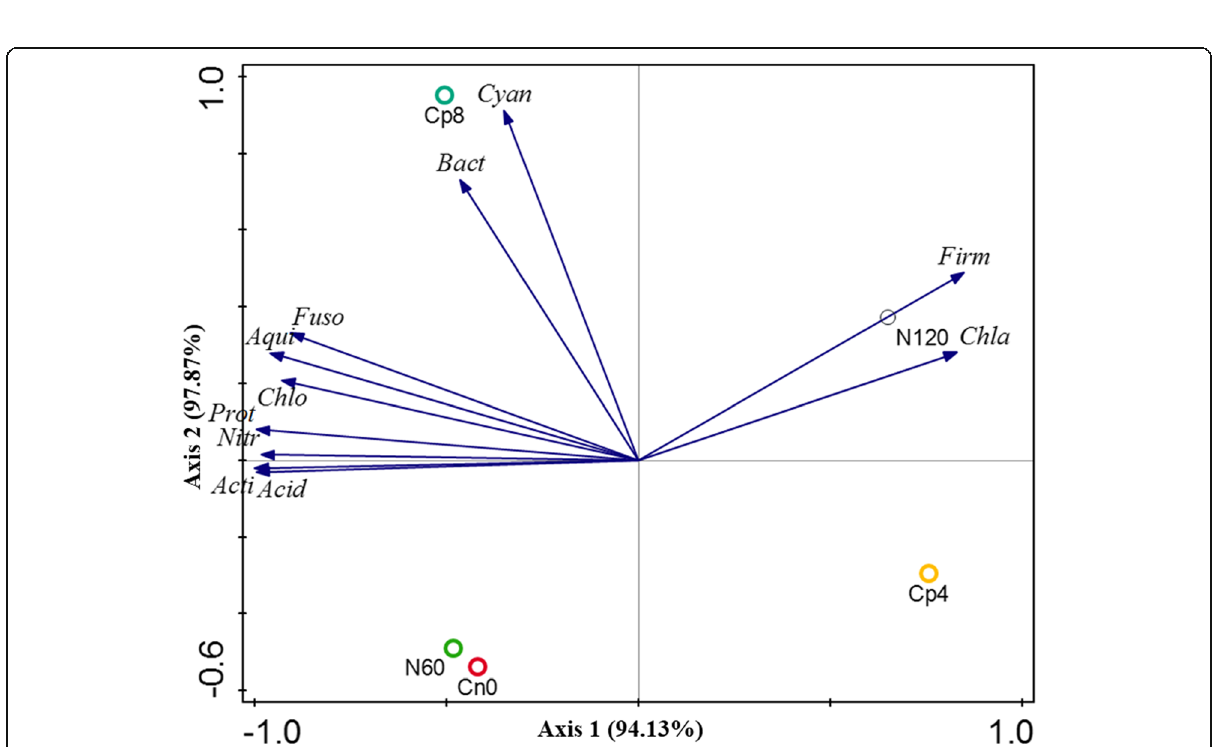
Fig. 2 PCA (principal component analysis) of the bacterial community structure associated with maize rhizosphere grown under different fertilization and unfertilized regimes (compost 8tons/ha — Cp8, compost 4 tons/ha — Cp4, control — Cn0, 60 kg/ha inorganic fertilizer — N60, 120 kg/ha inorganic fertilizer — N120), showing treatments as the key factors influencing the structural shift and shape of bacterial community at the rhizosphere soil samples. The percentages represent the observed